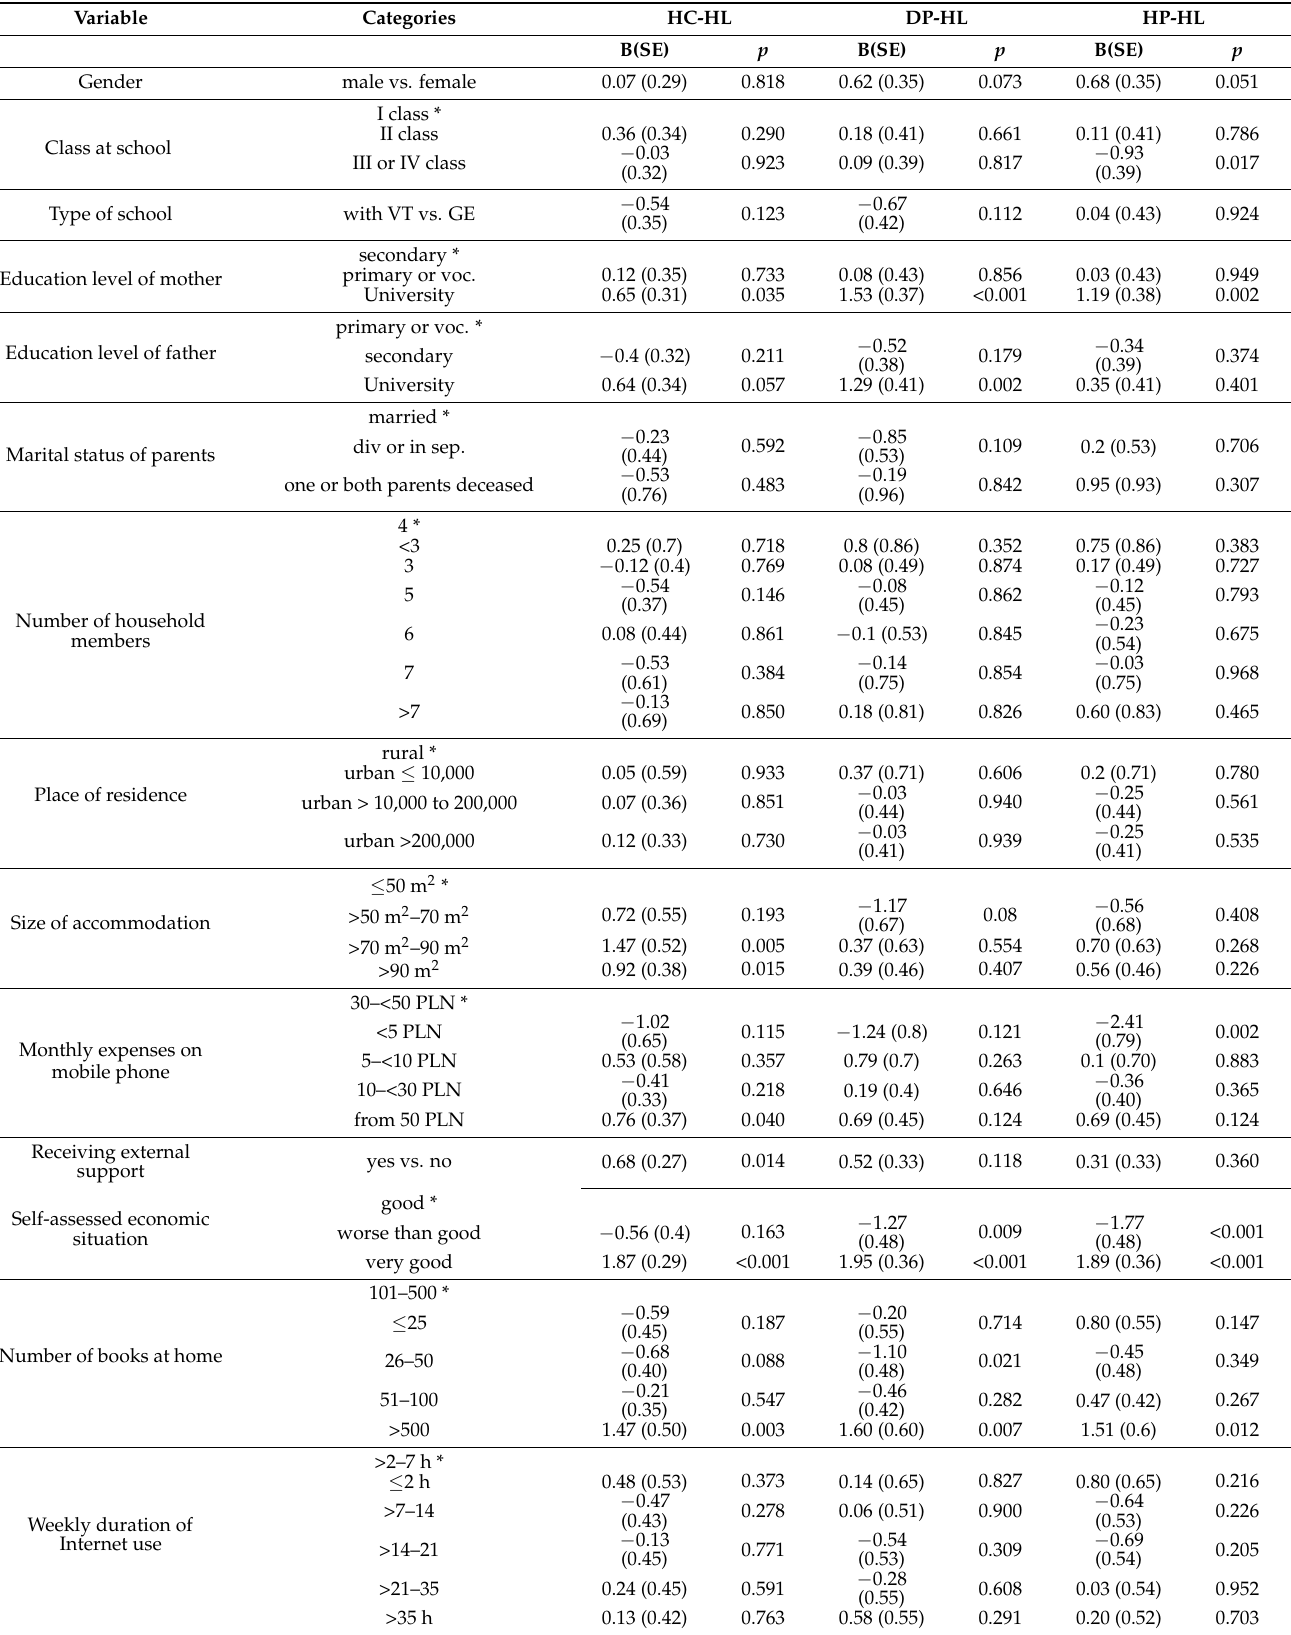
Table 6. Univariate linear regression models for HL sub-indices for appraisal and use of health